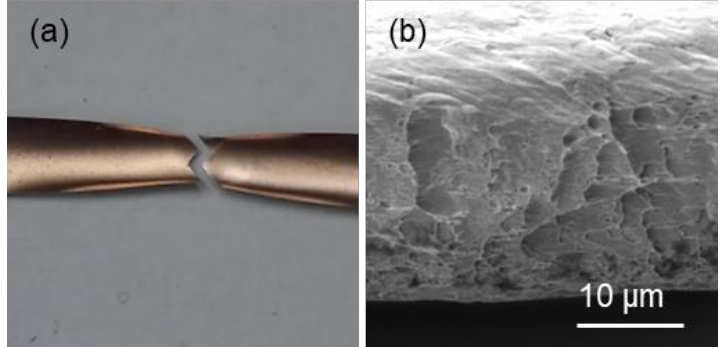
Figure 9. The ( a ) necking behavior and ( b ) fracture images of <111>-oriented nt-Cu after annealing at 250 °C for 180 min.